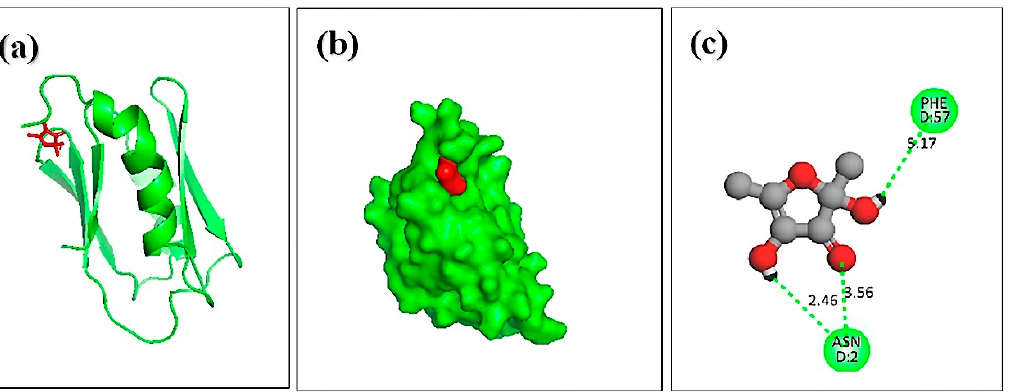
(Table 5, Figure 5) and 4H-pyran-4-one, 2, 3-dihydro 3, 5-dihydroxy-6-methyl-hemolysin II